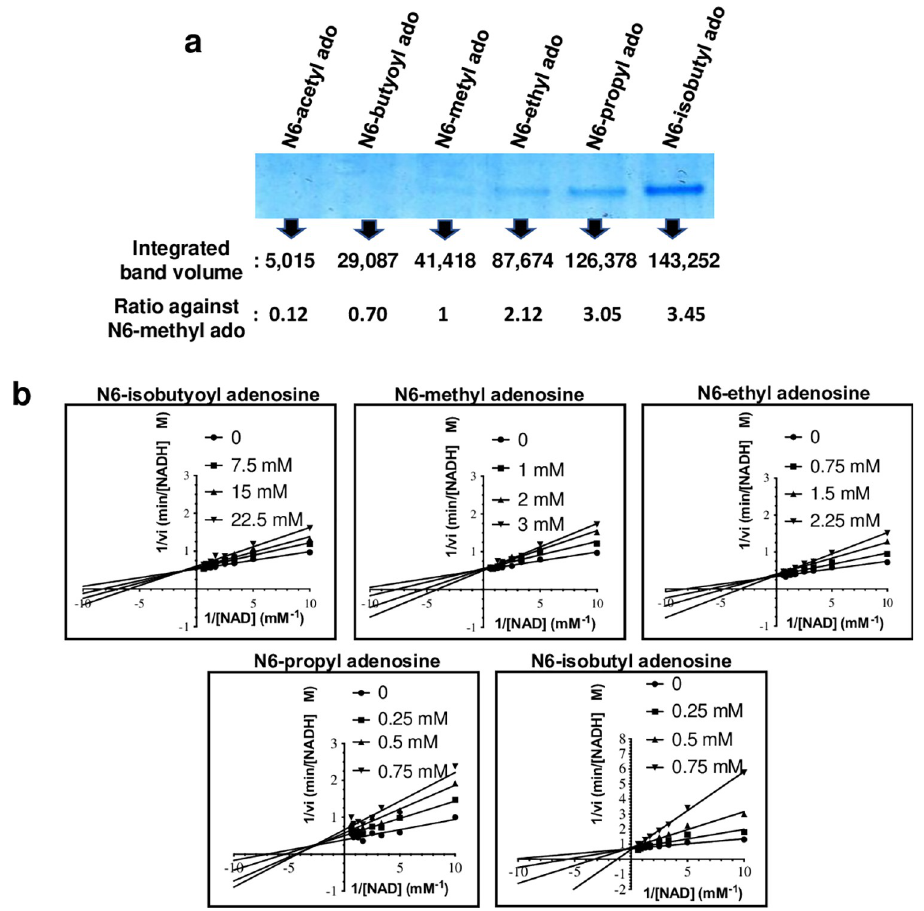
Fig 3. Characterization of synthesized compounds. (a) Analysis of six synthesized adenosine analogue compounds (including the lead compound, N6-methyl adenosine) with AlaDH by DLAC and densitometry analyses. The gel is cropped from the full-length gel that is presented in S6 Fig in S1 File . (b) Lineweaver-Burk plots to calculate the K i of five compounds based on their activity inhibition at indicated concentrations against AlaDH.